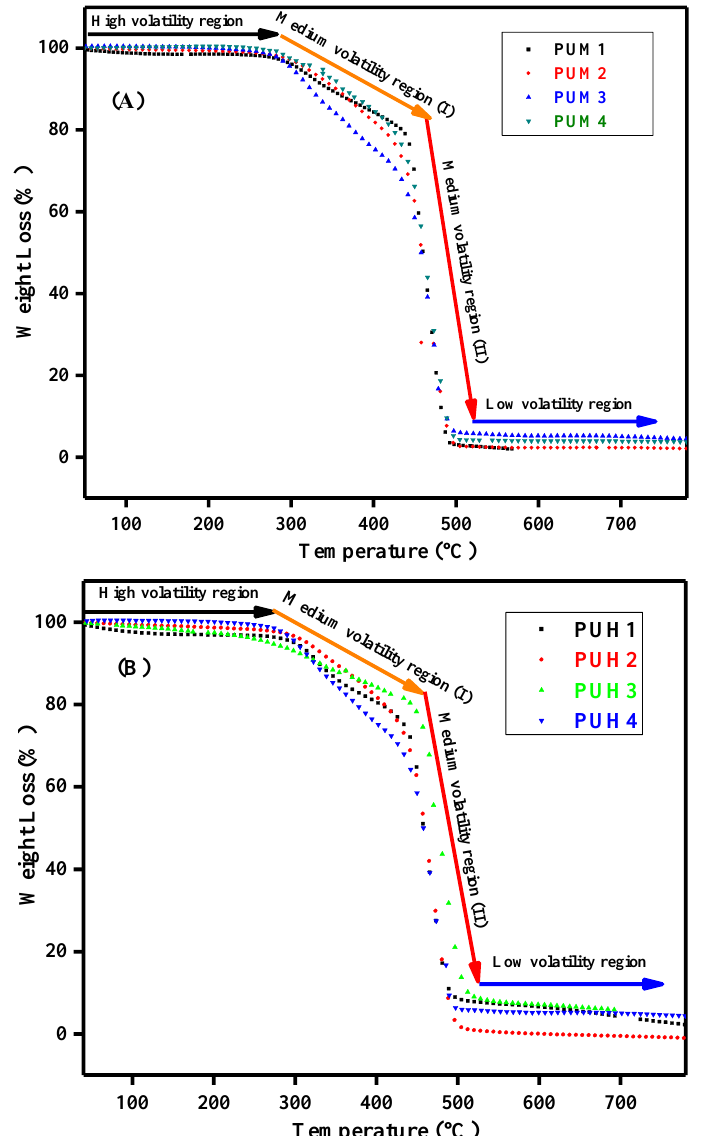
Figure 3. Thermalgravimetric analysis (TGA) thermograms of graphene oxide (GO) induced poly- urethane (PU) composites. ( A ) Representation of TGA curves of PUM series. ( B ) Representation of TGA curves of PUH series.